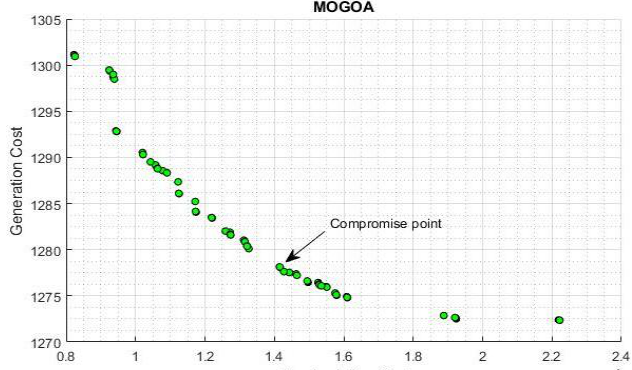
Figure 4. Convergence curve of Generation and